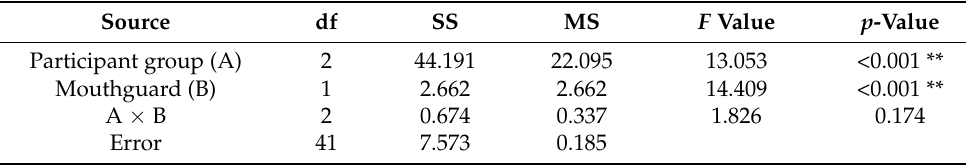
Table 1. Results of COP-FB displacement by a split-plot design analysis.